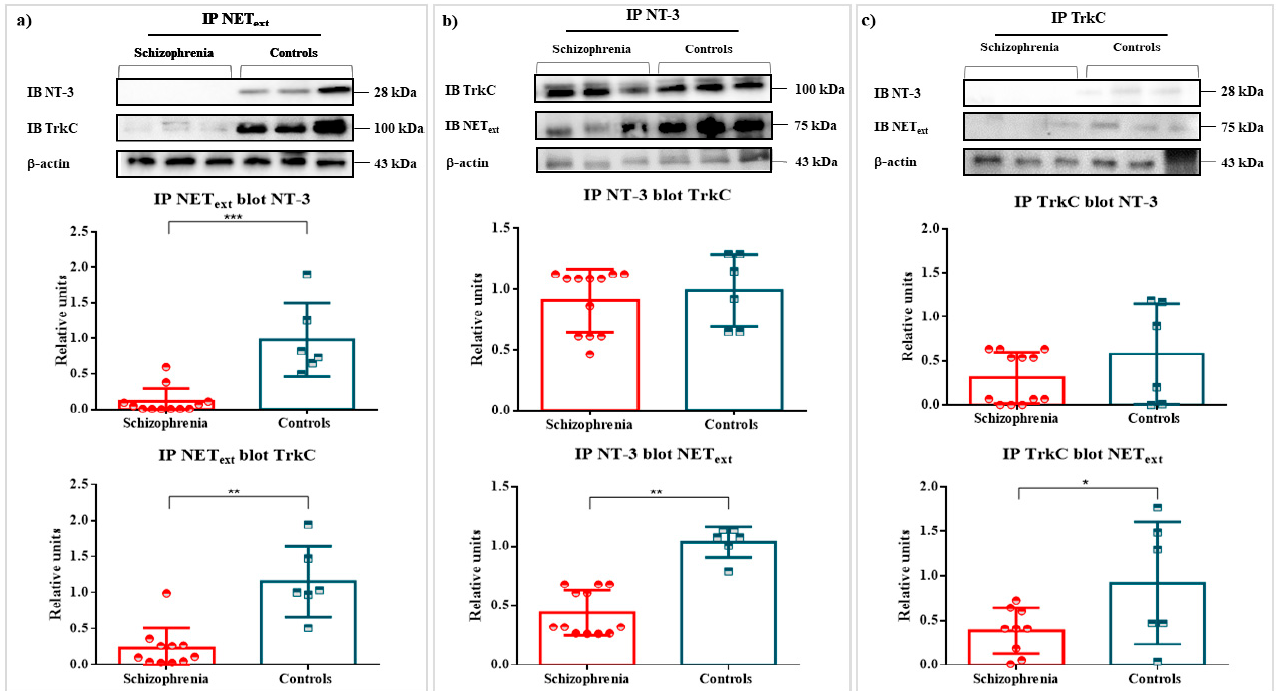
Figure 2. Co-IPs of NEText and NT-3 or TrkC in T cells of patients with schizophrenia and healthy controls. Legend: Co-IPs of NEText, NT-3, and TrkC in T lymphocytes of patients with schizophrenia and controls. Legend: Measurement of NEText and TrkC levels in T cells and NT-3 levels in plasma, and their respective scatter plots and bar graphs (mean ± SD). ( a ) Co-IP NEText-blot NT-3 (12 patients with schizophrenia vs. 6 controls; p = 0.0003) and Co-IP NEText-blot TrkC (10 patients with schizophrenia vs. 6 controls p = 0.0020). ( b ) Co-IP NT-3-blot TrkC (12 patients with schizophrenia vs. 6 controls; p > 0.05) and Co-IP NT-3-blot NEText (12 patients with schizophrenia vs. 6 controls; p = 0.0021). ( c ) Co-IP TrkC-blot NT-3 (12 patients with schizophrenia vs. 6 controls; p > 0.05) and Co-IP TrkC-blot NEText (9 patients with schizophrenia vs. 6 controls; p = 0.030) (* p < 0.05; ** p < 0.01 and *** p < 0.001).